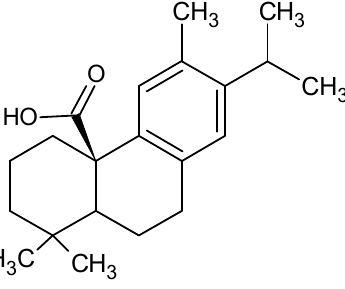
Figure 1. The chemical structure of carnosic acid.